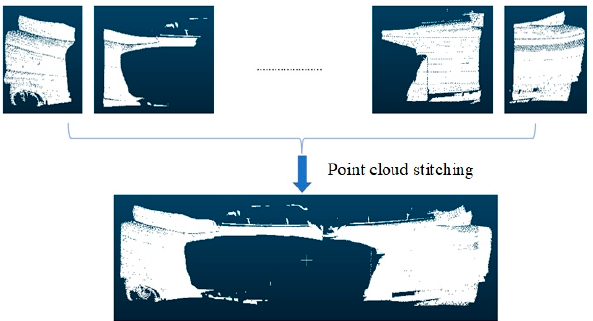
Figure 20. Complete initial point cloud stitching of the vehicle nose.